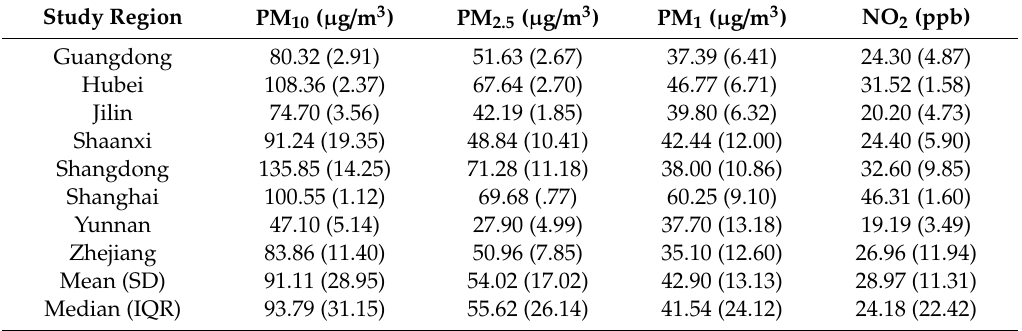
Table 2. Distributions of 3-year average concentrations of air pollutants in 64 communities in China.